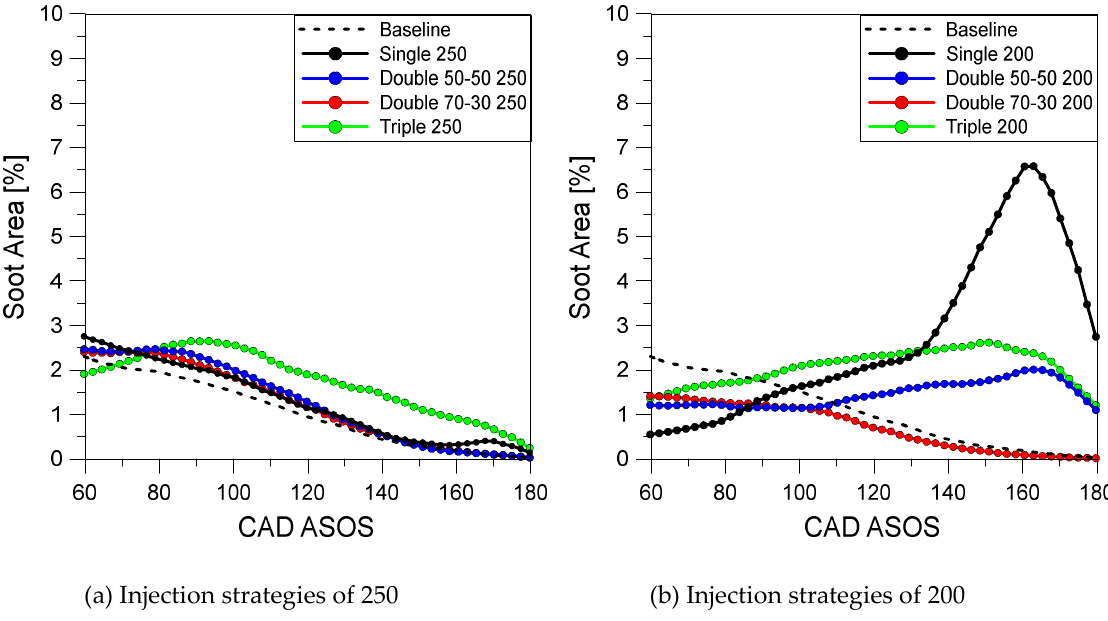
Figure 17 . Soot total area with respect to piston cross-section for 250 (a) and 200 (b) injection